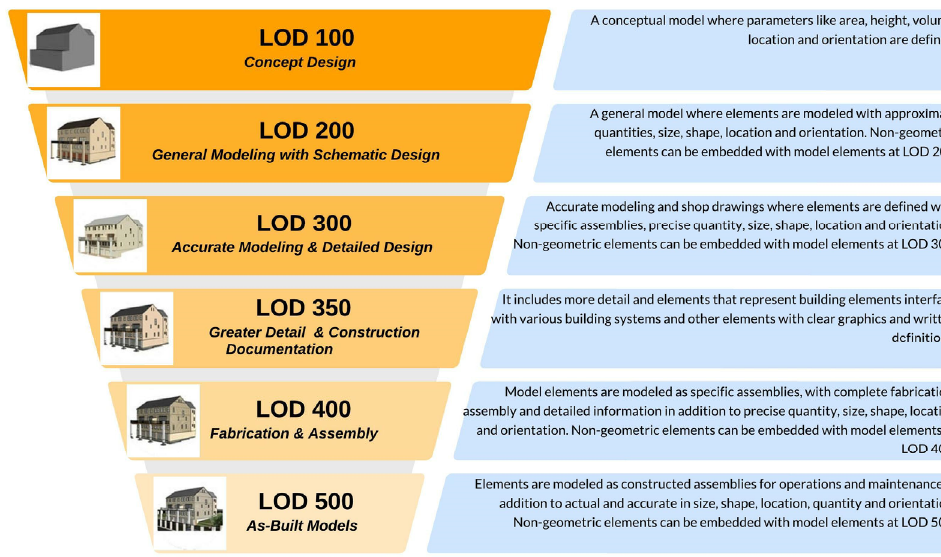
Figure 5. Levels of Development (LOD) for BIM as defined by the AIA (inspired by [58]). Past studies propose an adaptation of the standard LOD definitions to HBIM, such as Castellano-Roman and Pinto-Perto’s [59] five “Levels of Knowledge” (LOK) for HBIM. Heritage Scotland proposes three LODs applicable to HBIM, which range from standard CAD outputs (Level 0), data transferred to a 3D CAD environment (Level 1), and reality capture data used for parametric 3D modeling and collaboration (Level 2) [1].